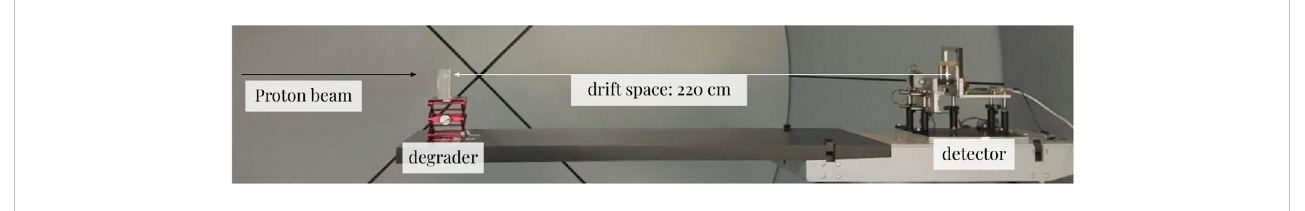
FIGURE 3 Experimental setup at the RPTC with a PMMA block as the energy degrader on the left and the CMOS detector in its housing on the right.